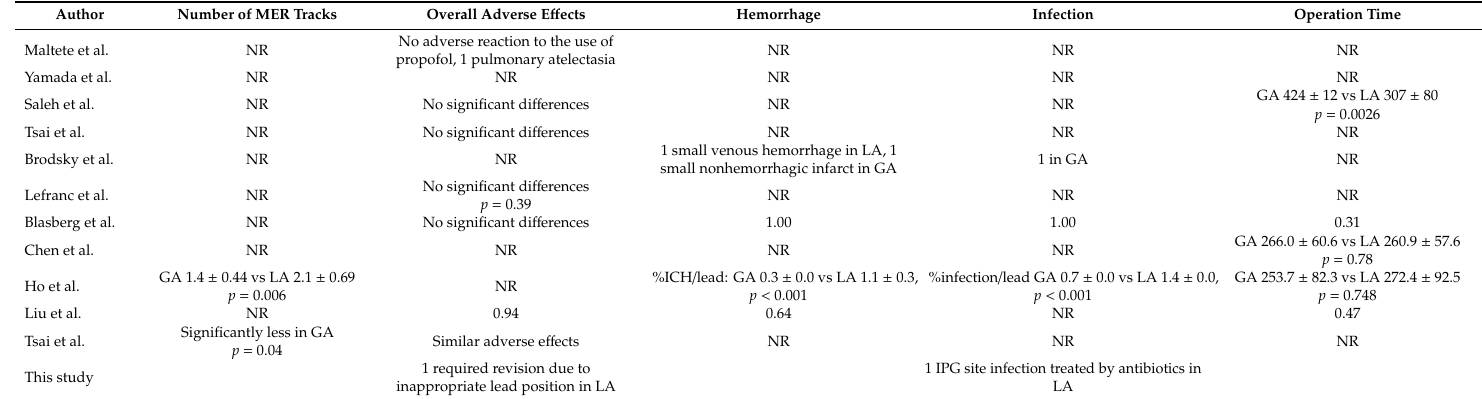
Table 4. Summary data of published literature comparing clinical outcome e ff ect of after subthalamic nucleus deep brain stimulation under general anesthesia and local anesthesia in patients with Parkinson’s disease: Perioperative